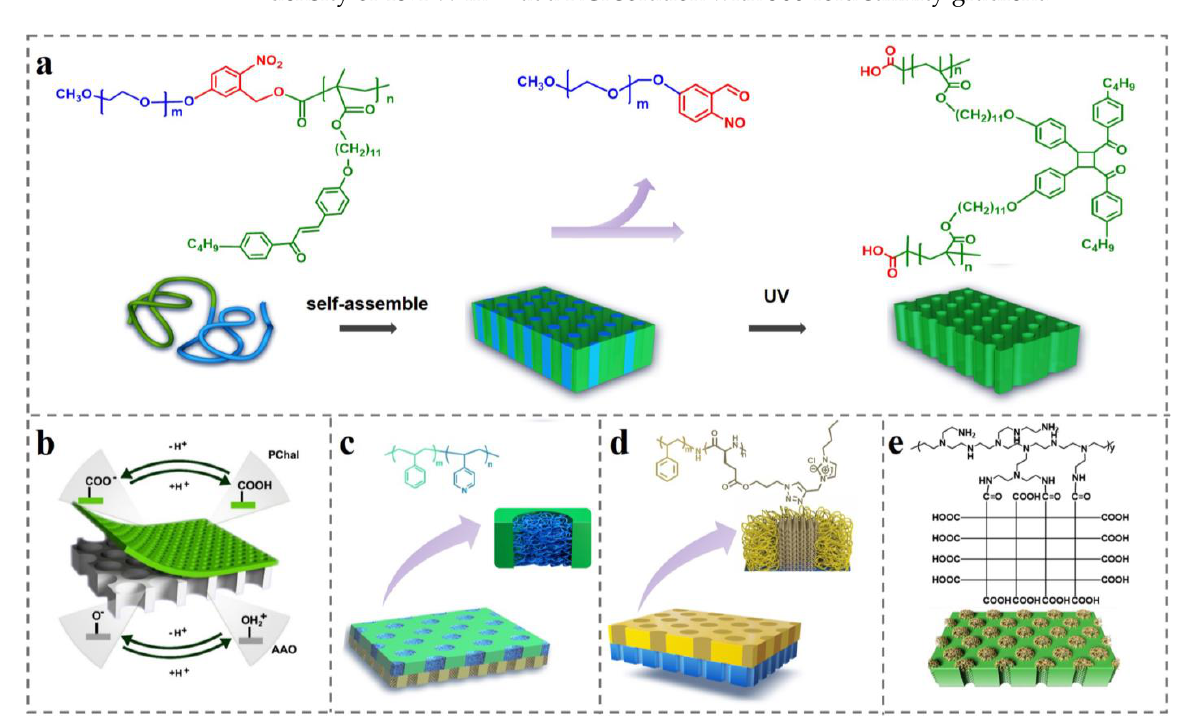
Figure 8. ( a ) Structural formula of PEO-hv-PChal molecule which can be degraded and cross-linked simultaneously under UV light and its self-assembly process [166]. ( b ) Schematic diagram of BCP-AAO asymmetric nanochannel membrane structure [166]. ( c ) Schematic diagram of PS-b-P4VP nanopore channel and schematic diagram of asymmetrical ultrathin Janus film hybridized with PEO-b-PChal porous membrane [168]. ( d ) Schematic diagram of the nanopore channels of PS-b-PPLG and its hybridization with PEO-b-PChal porous membrane to form a membrane with asymmetric nanopore channels [169]. ( e ) Schematic diagram of the molecular chain structure of PEO-b-PChal and polyethyleneimine and their hybridization to form mushroom-like asymmetric nanopore channels [170].